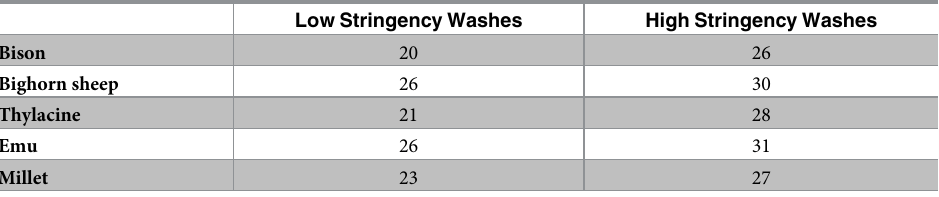
Table 3. PCR cycle number for indexing amplification of mtDNA enriched libraries (determined using qPCR). Low Stringency